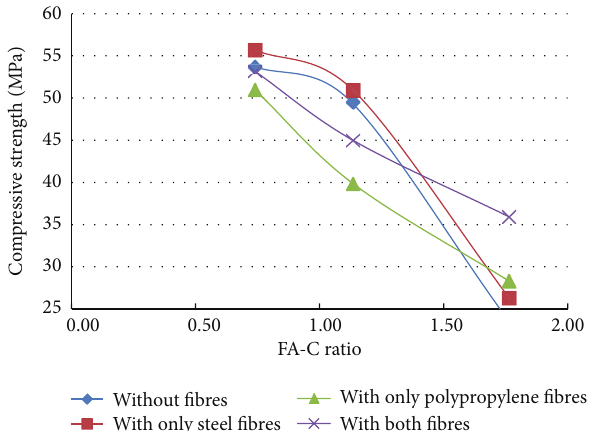
Figure 9: Effect of addition of fibres (CS-S ratio = 1.0).